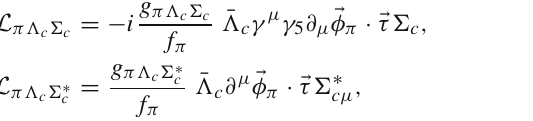
Fig. 1. The rescattering between final states